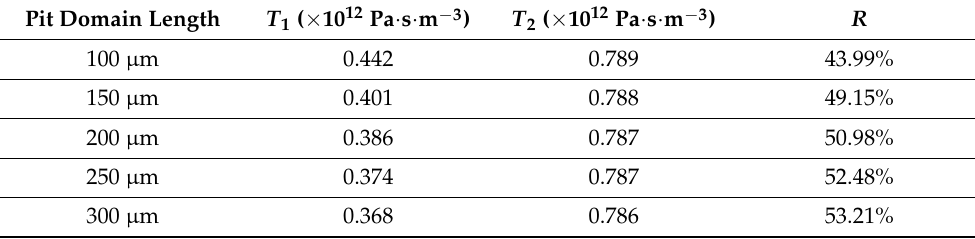
Table 3. Influence of the pit domain length on the radial transmission